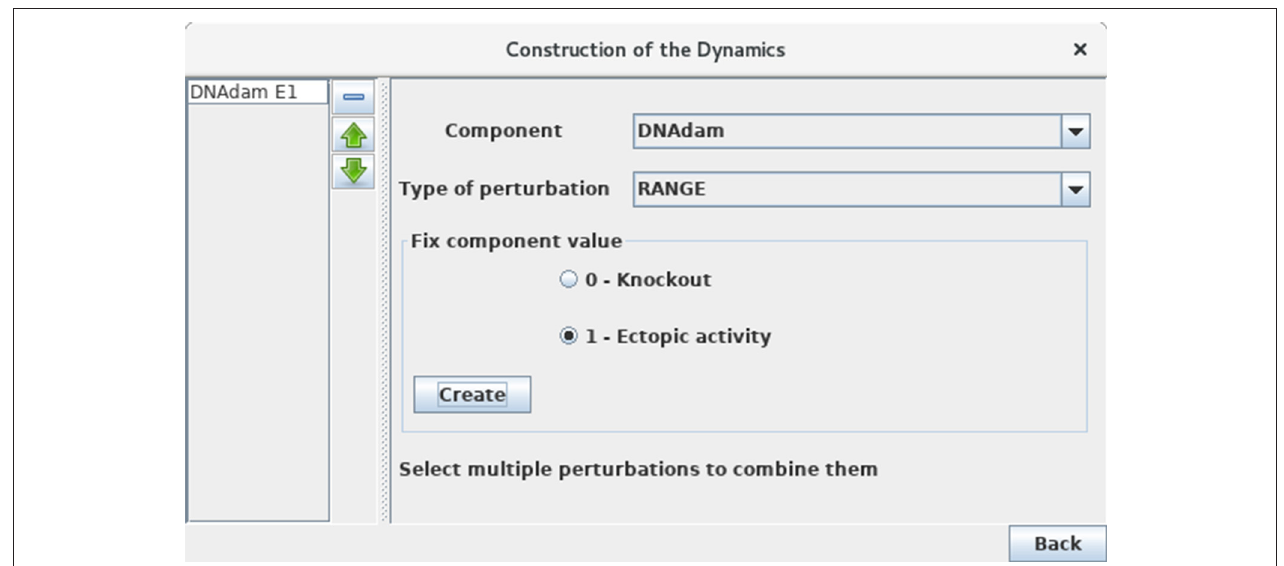
FIGURE 10 | Perturbation specification. This window can be activated from the simulation launching window ( Figure 5 ) and various other windows, including the Compute stable states window. It enables the specification of various kinds of model perturbations, including loss-of-function and gain-of-function mutants. The figure illustrates the specification of a simple blockade of the level of DNAdam to level 1.